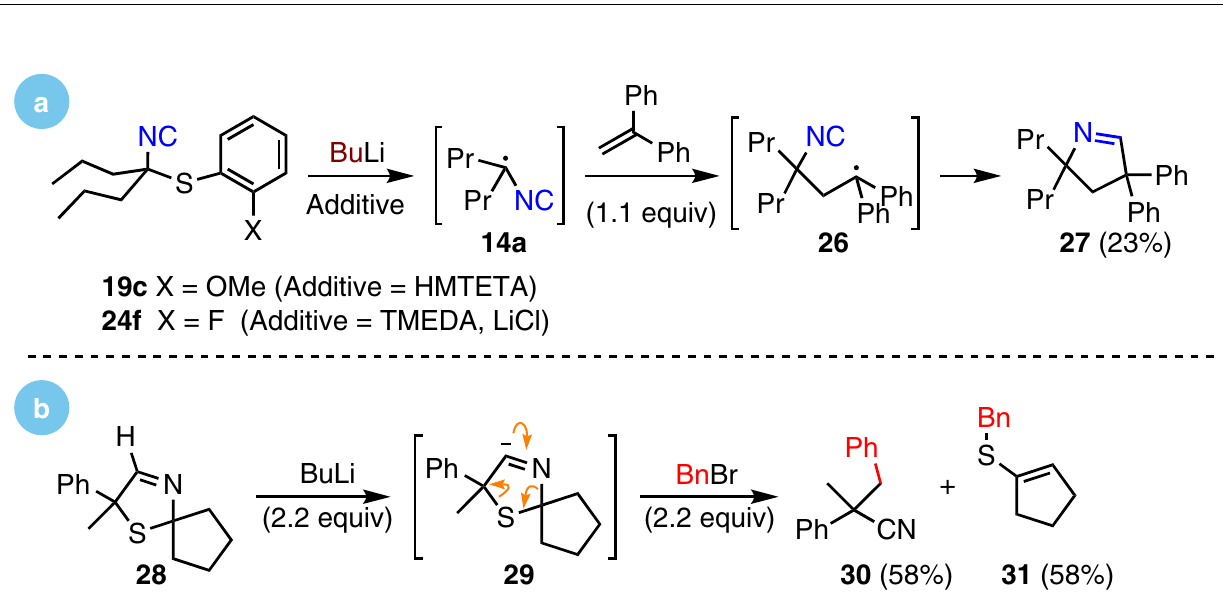
Fig.6|Calculatedenergeticsofdearomatization – dislocation-couplingsequence. Freeenergies(kcal/mol)werecomputedattheUB3LYP-D3/def2-TZVPP-SMD(THF)// UB3LYP-D3/def2-SVP-SMD(THF) level of theory.